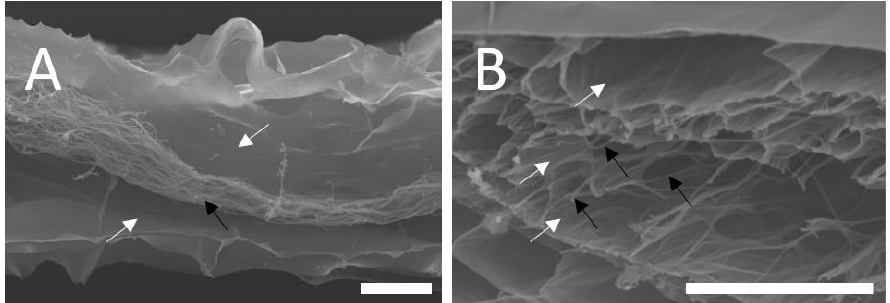
Figure 8. SEM images of nonwoven-reinforced hydrogel. Nonwoven-reinforced hydrogels were produced by sandwiching ( A ) PCL/P 11 -8 or ( B ) PCL electrospun nonwoven between silicone moulds and glass slides, UV-curing collagen-GMA hydrogel on both sides and lyophilising the scaffold. ( A ) Pore structures of collagen-GMA could be seen on both sides of the scaffold (white arrows), whilst alignment of the nonwoven fibres was retained (black arrow). ( B ) Higher magnification showed sheets of collagen-GMA (white arrows) between aligned nonwoven fibres (black arrows) indicating integration at the fibre level of both materials. Scale bar is 100 µ